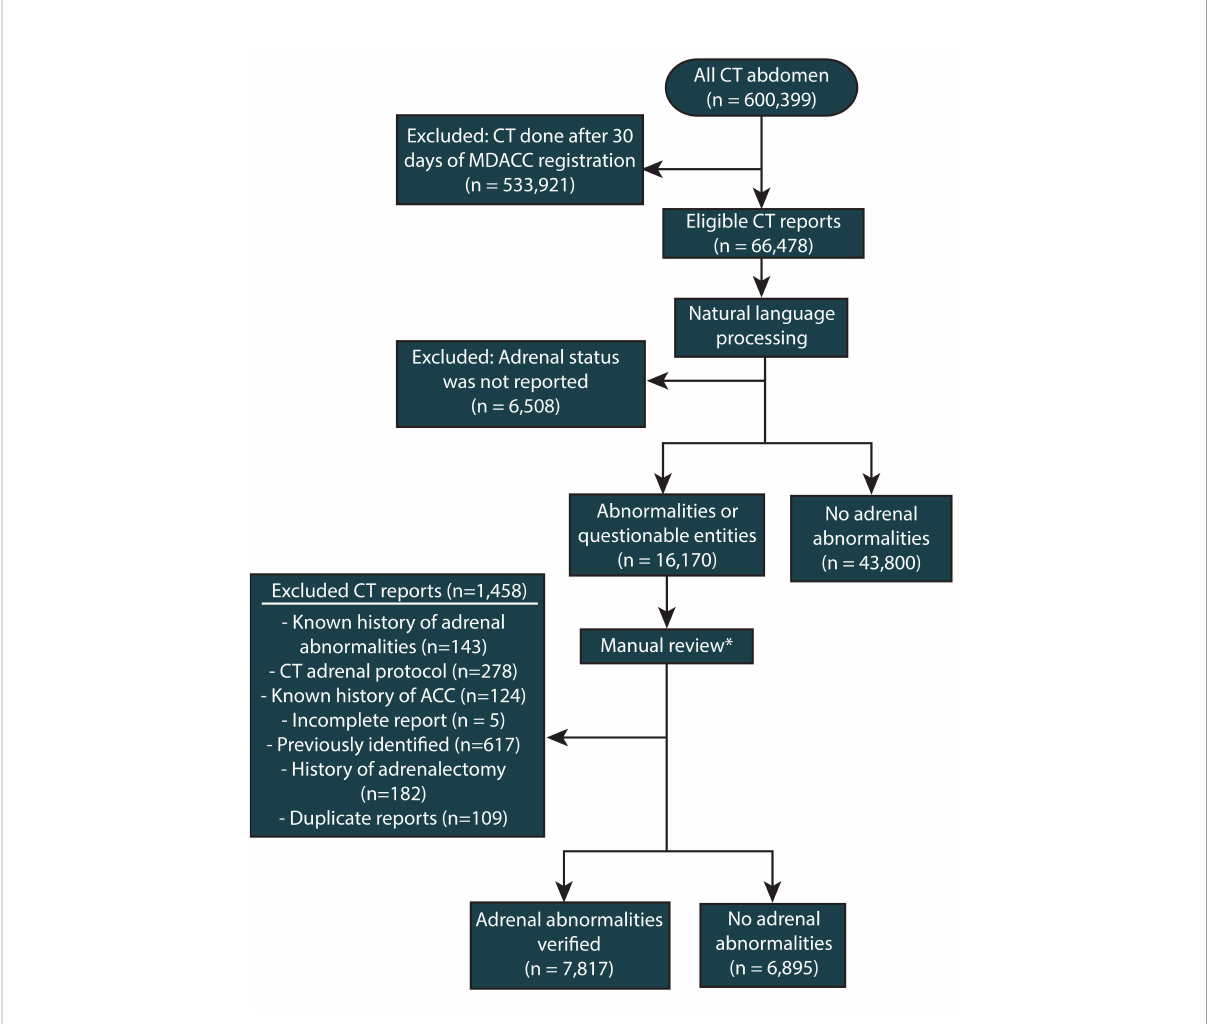
FIGURE 1 Flow diagram for the steps in identifying the study participants and determining eligibility. * Manual chart review done by three independent abstractors. To assess the inter-rate agreement, 300 charts were reviewed by all the abstractors, yielding a Fleiss kappa of 0.893, which suggests almost perfect agreement between the